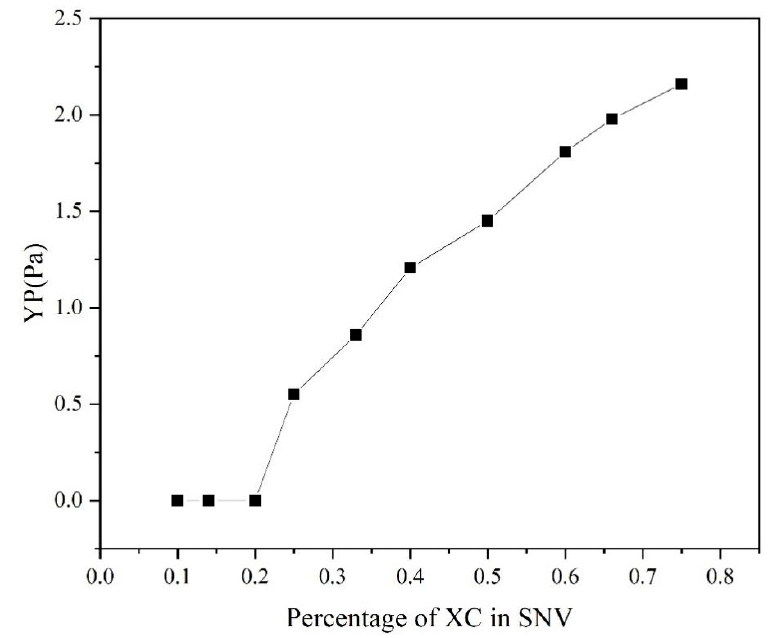
Figure 8. YP of the SNV–Bent systems with different ratios of the two components.